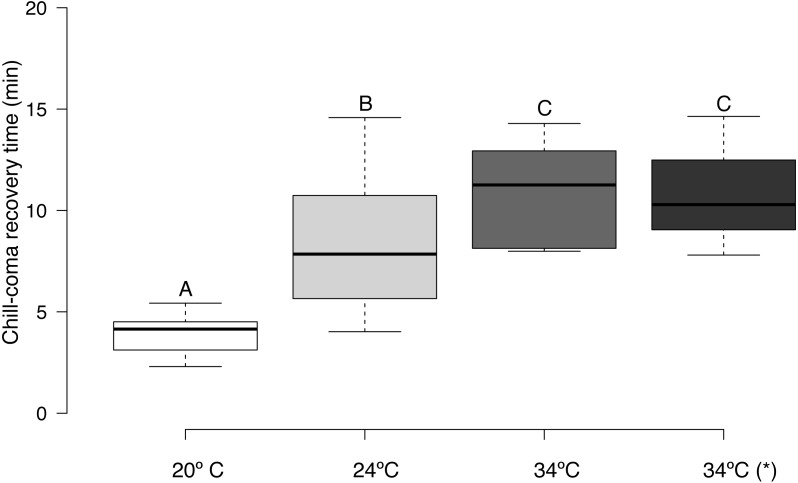
Box plots of chill-coma recovery times of adult Apis mellifera subjected to experimental temperatures.Tukey-style whiskers were used (Krzywinski & Altman, 2014; Spitzer et al., 2014). *, thermal tolerance of control group (see text for details). Different letters denote significant differences among treatments (p < 0.05).